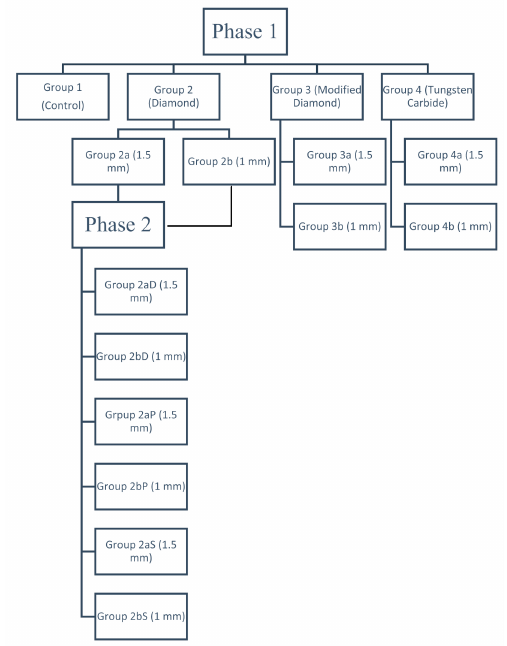
Figure 1. Flowchart of the experimental